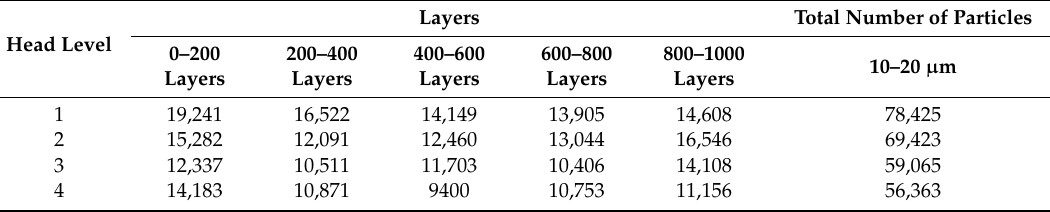
Table 8. Variation in the number of fine particles percolated with the 30% fine content (10–20 µ m).